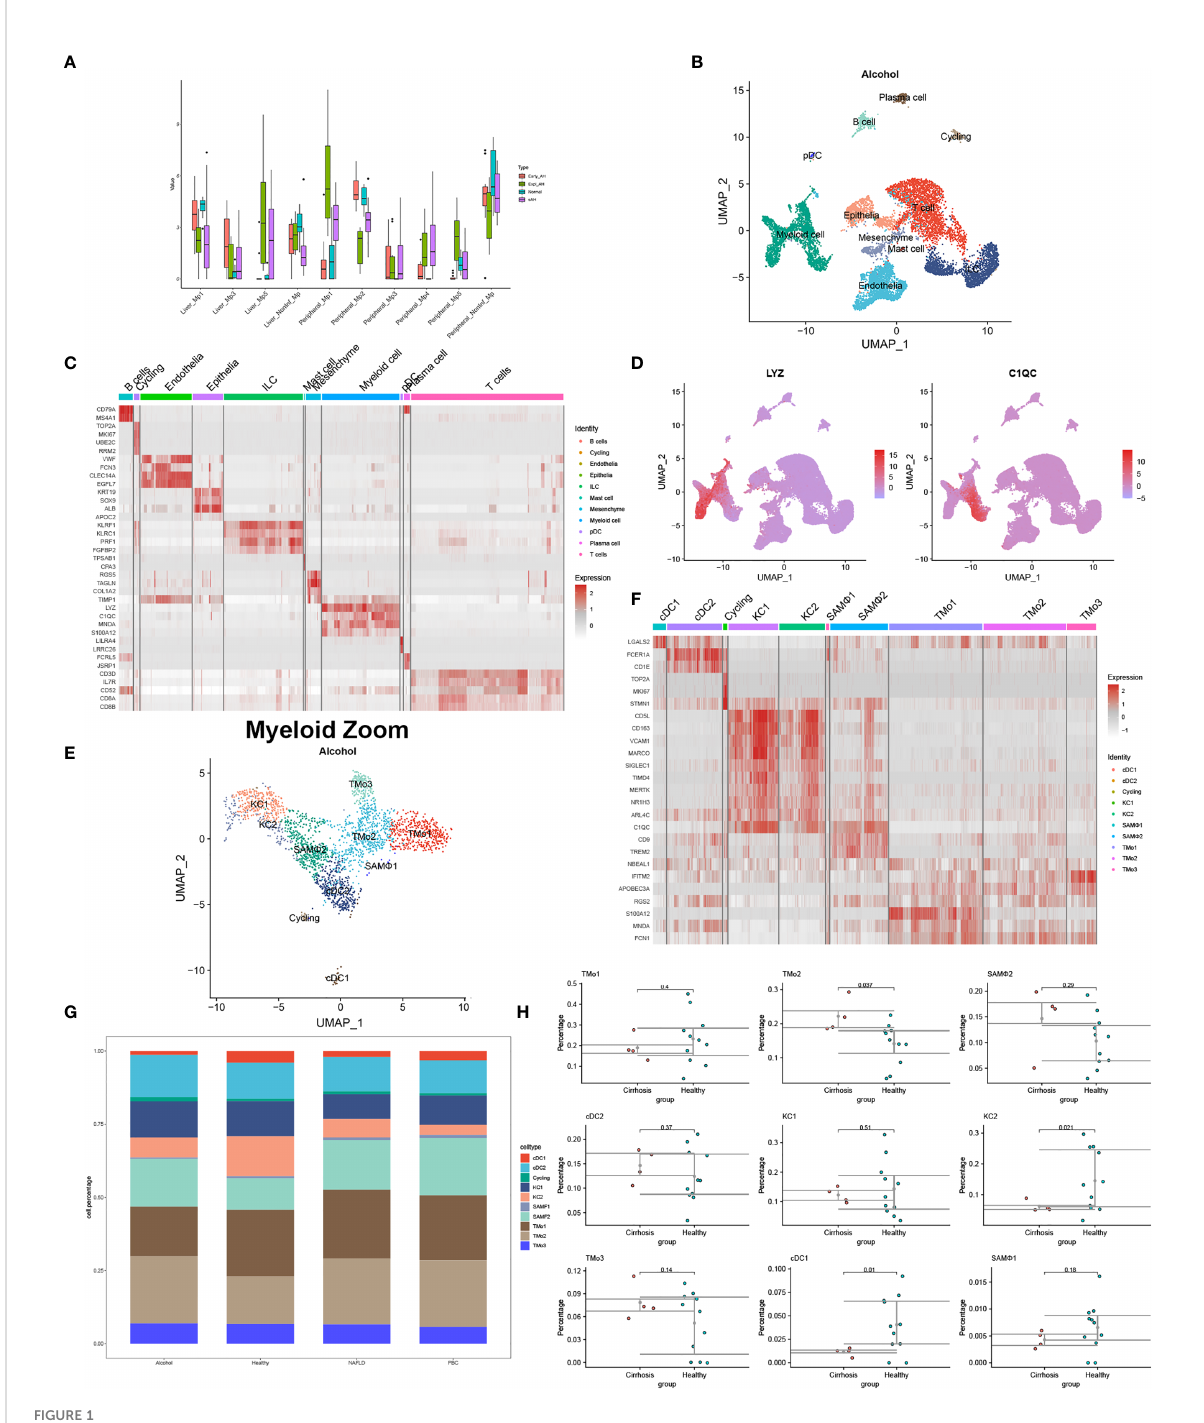
FIGURE 1 Identi fi cation of myeloid landscape in human alcoholic liver disease (ALD) and liver cirrhosis. (A) Changes of macrophages in the progression of ALD come from the mapping of single-cell sequencing data to RNA-seq. (B) Clustering 12382 cells from two cirrhotic human livers caused by alcohol and cell lineage as inferred from expression of marker gene signatures. ILC, innate lymphoid cell; pDC, plasmacytoid dendritic cell. (C) Heat map: cell types and marker genes. (D) Expression of LYZ and C1QC mRNA. (E) Myeloid cells were isolated from (B) and re-clustered with Seurat_4.1.0. (F) Heat map: myeloid cell types and marker genes. (G) The proportion of myeloid cells among normal patients and liver cirrhosis caused by alcohol, non-alcoholic fatty liver disease, and primary biliary cirrhosis. (H) Percentages of myeloid subpopulations in fi ve healthy versus two cirrhotic livers, with a signi fi cant difference in the proportion of TMo2, scar-associated macrophages, KC2, and cDC1 between the two groups ( t